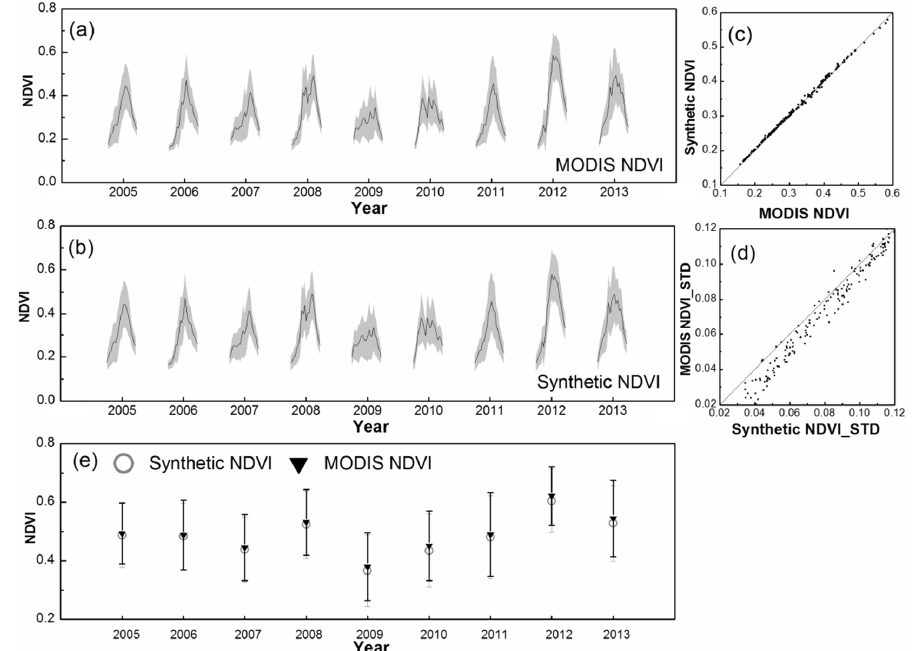
Figure 5. Temporal variations of the regional mean and standard deviation (shaded area) of NDVI for grasslands in the study areas during 2005–2013 (growing season). ( a ) MODIS NDVI; ( b ) synthetic NDVI; ( c ) scatter plots between MODIS NDVI and synthetic NDVI at 8-d intervals; ( d ) scatter plots between the standard deviation of MODIS NDVI and synthetic NDVI at 8-d intervals; ( e ) MODIS NDVI max (black) and synthetic NDVI max (gray). Error bars represent the standard deviations of MODIS NDVI max (black) and synthetic NDVI max (gray).